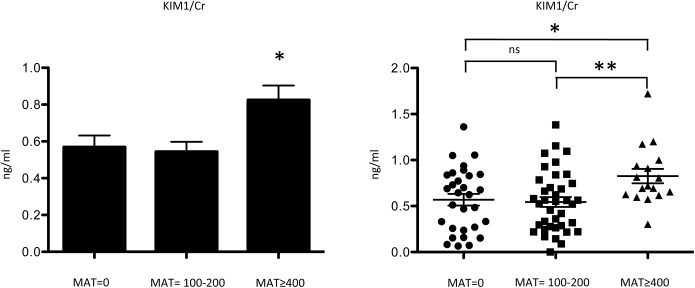
Kidney injury molecule–1 creatinine ratio (KIM1/Cr) level of three different MAT titer groups for township cohort in 2011 (Negative, titer = 100–200, titer ≥400).*p<0.05, **p<0.001.